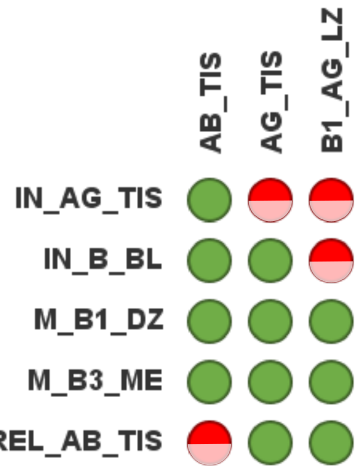
Figure 6. Example knockout matrix. The name of a knocked out transition is indicated by the label of the row. The name of an affected place is indicated by the label of a column. Half-filled red circles denote that the knockout had an effect; green circles denote no effect of the knockout. The knockout matrix is computed by an in silico knockout based on Manatee invariants [36]. We chose five transitions and three places. The knockout of transition IN_AG_TIS (first row) stops the invasion of antigens. No antigen enters the tissue (red circle for AG_TIS ) and no activated B cell enters the light zone (red circle for B1_AG_LZ ), though the production of antibodies may continue to be active (green circle for AB_TIS ). Overall, the majority of circles are green (no effect of a knockout). The knockout matrix indicates the robustness of the immune response to single knockouts; see